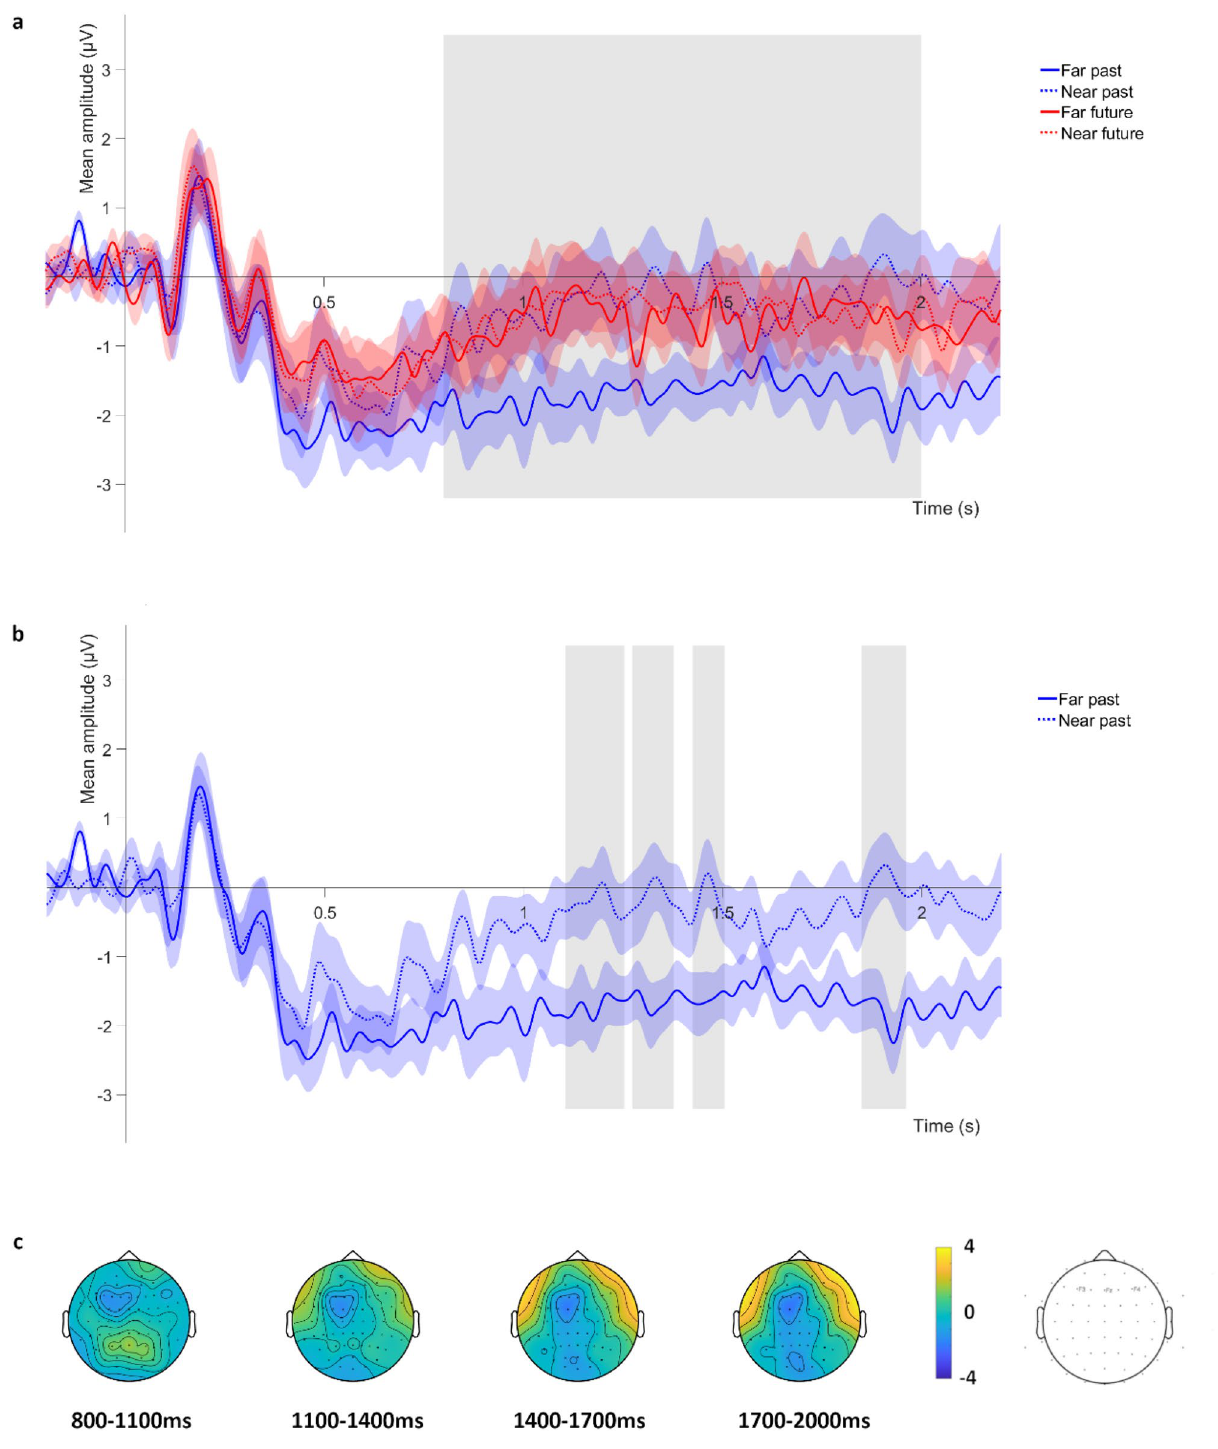
Figure 3. Electrophysiological data for the LFE time window. ( a ) Mean amplitude of the ERP averaged across the three electrodes selected for the LFE analyses (F3/4 and Fz). The grey rectangle indicates the time window of this component (from 800 to 2000 ms). ( b ) Far past vs near past comparison for the LFE, grey rectangles show the clusters of time points for which the comparison was significant. For ( a ) and ( b ), shadowed regions indicate the standard error of the mean for each experimental condition. Panel ( c ) displays the temporal course of the LFE, averaged across